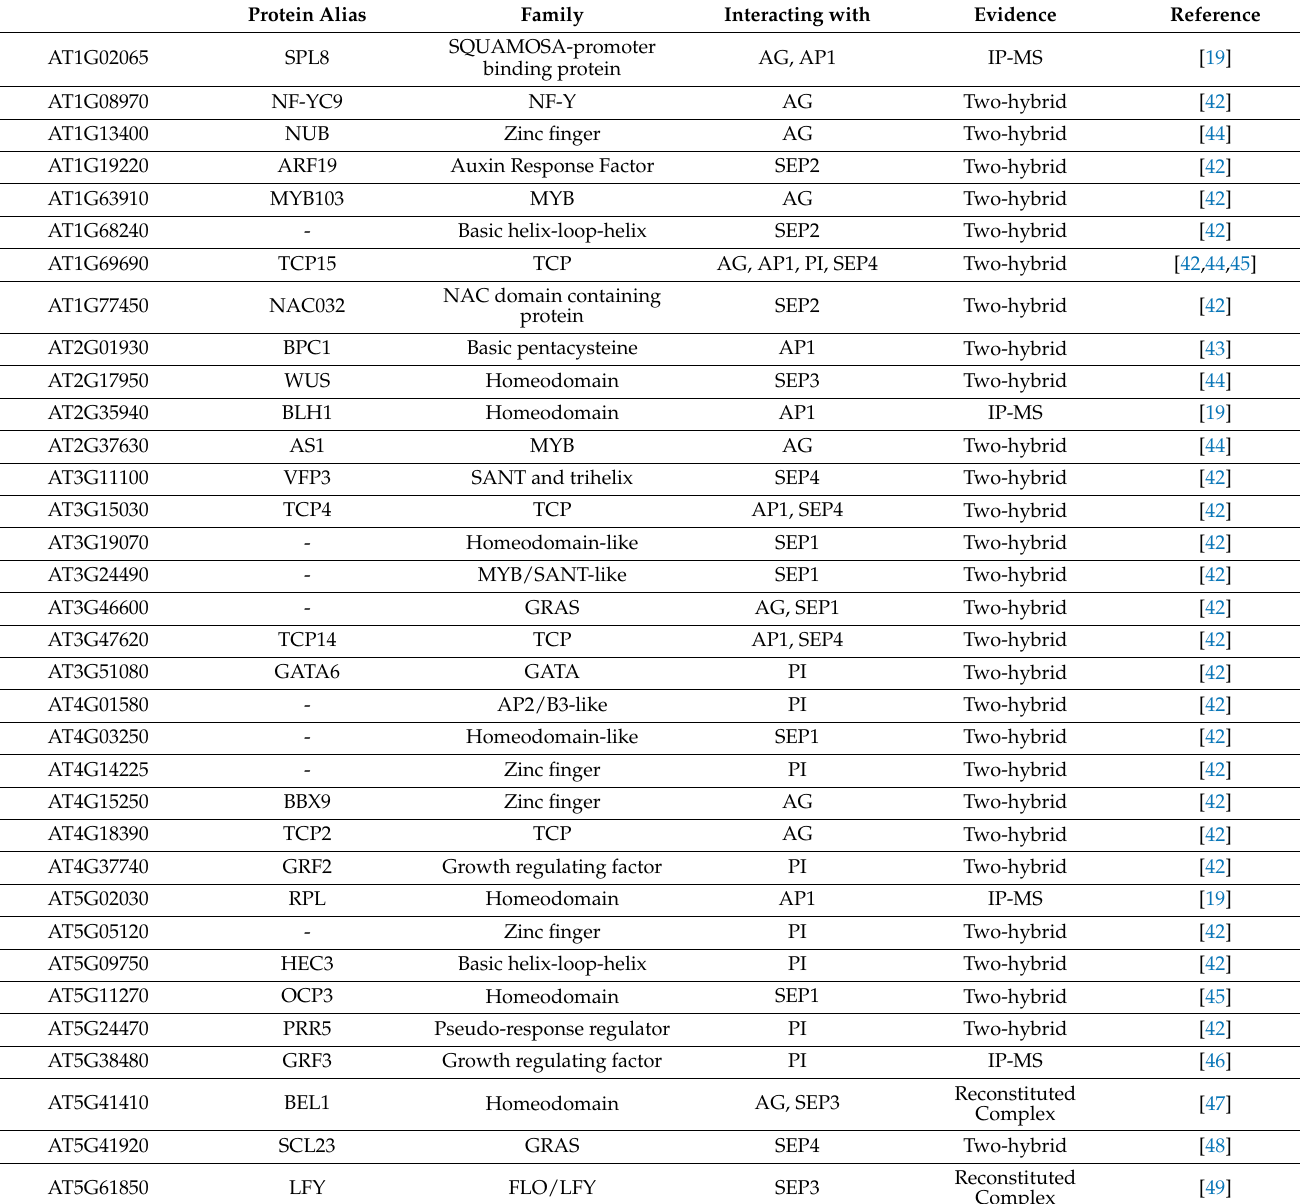
Table 1. Non-MADS-domain transcription factors identified as interactors of floral organ identity